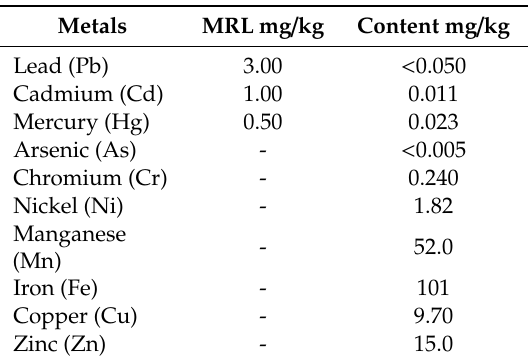
Table 10. Residue levels and MRLs of